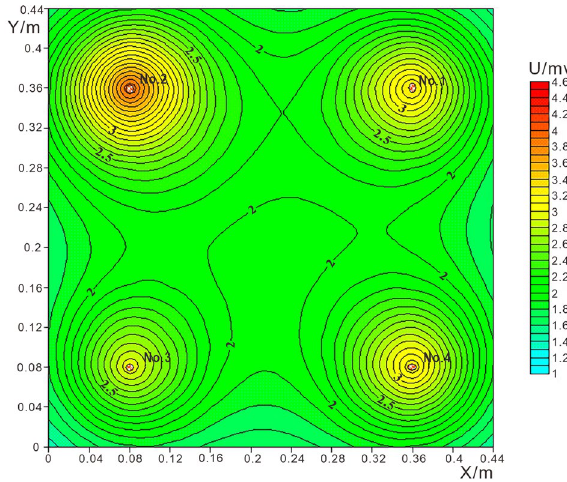
Figure 6. 12 × 12 Grid theory detection potential contour map.